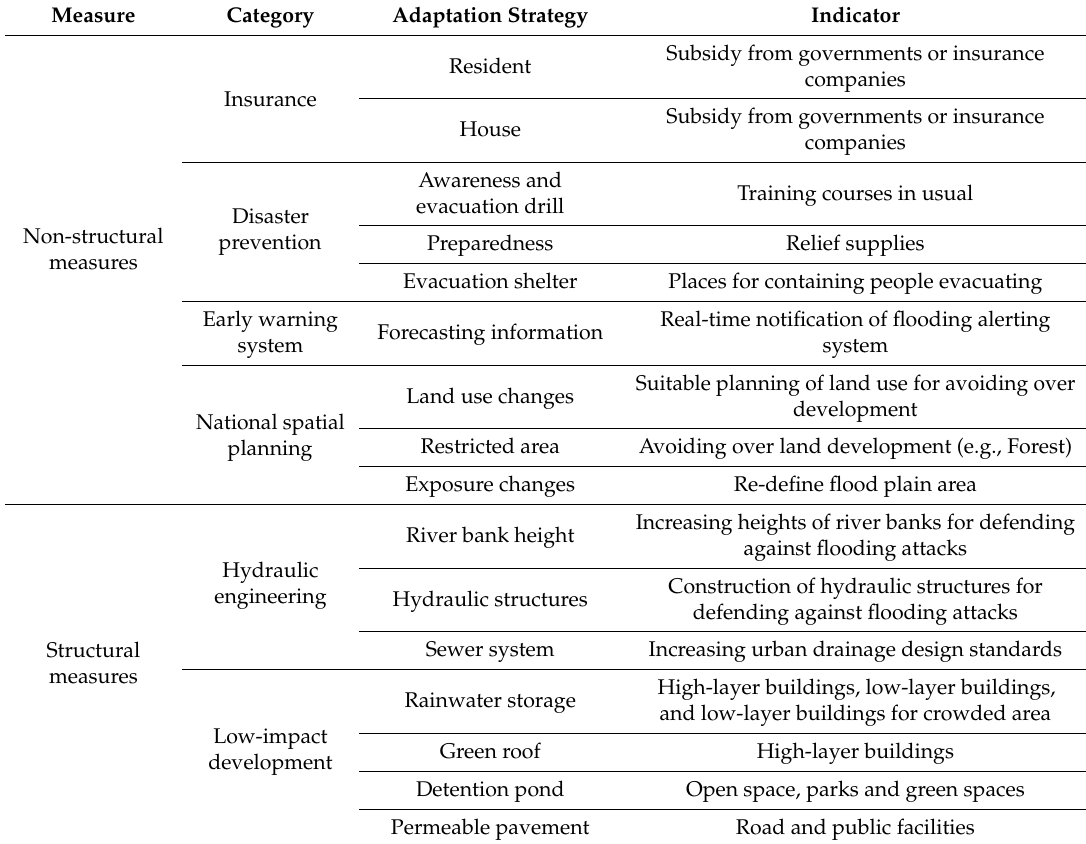
Table 8. The potential adaptation strategies for non-structural and structural